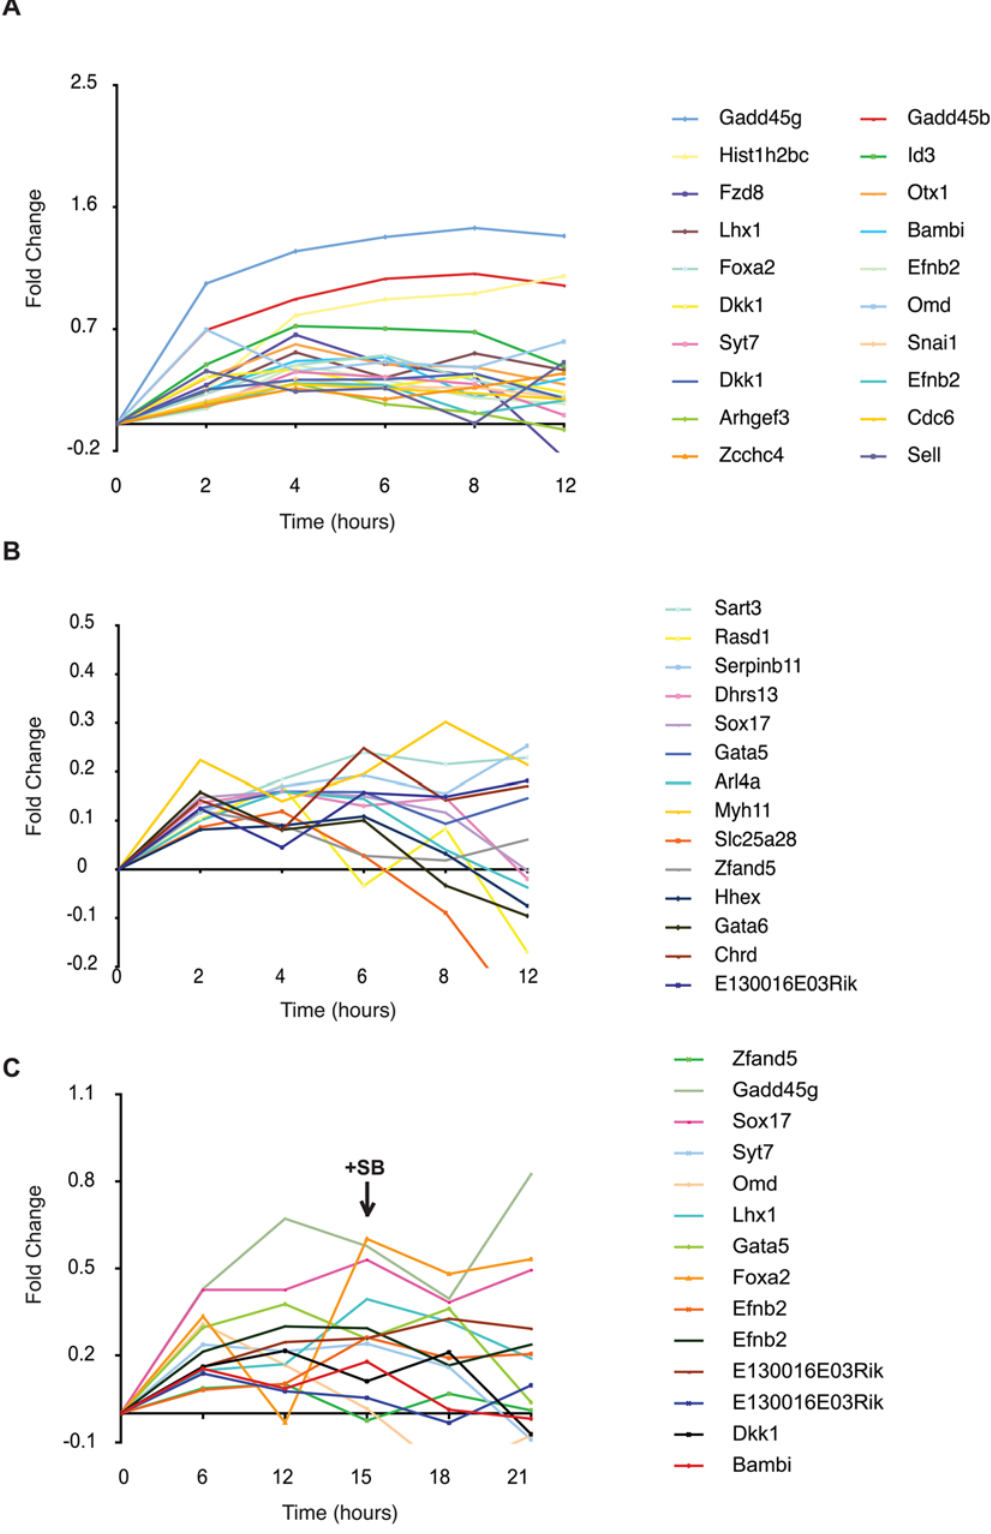
Figure 6. Expression profile of known Nodal-regulated genes in the TAG1 Smad2/3 time-course databases. Gene expression patterns of known Nodal-regulated genes were analysed and plotted as trends to show the changes in the expression during the modulation of Smad2/3 in the absence (A and B) or presence (C) of protein synthesis. Relative level of gene expression is represented as fold-change (y-axis) in log scale against time (x-axis). All samples were normalised to the 0 time point. Genes with at least one set of probes upregulated ( $ 2-fold) 2 hours after Smad2/3 activation are shown in (A and B ) and genes with one set of probes upregulated ( $ 1.2-fold) 6 hours after Smad2/3 activation in the Dox/ SB15 experiment are shown in (C) . The values of fold-change for the genes in these graphs are shown in Tables S5 and S6.